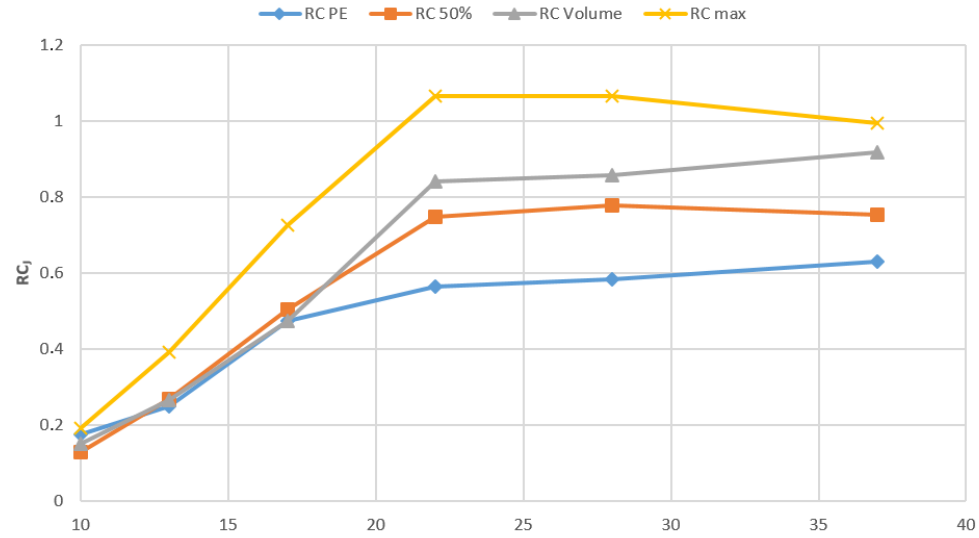
Figure 9. Recovery Coefficient (RC) as a function of the insert diameter for the NEMA/IEC phantom using different segmentation methods.